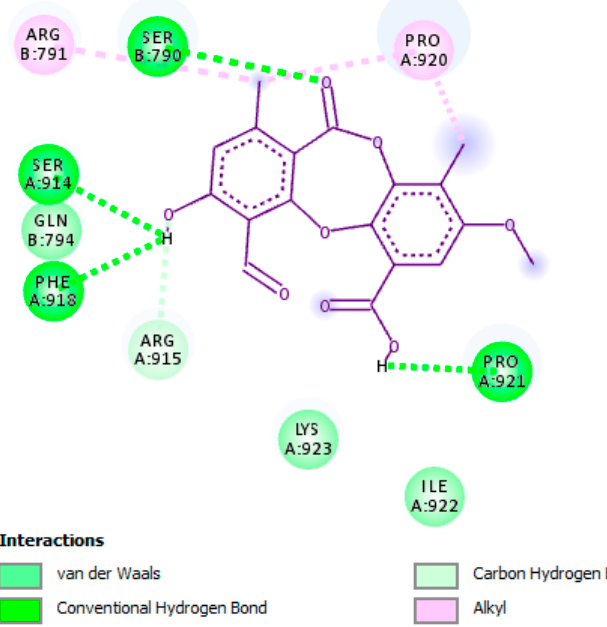
Figure 2. Molecular interaction of psoromic acid (PA) with the active site of HSV-1 DNA polymerase. Amino acid residues involved in HSV-1 DNA polymerase stabilization along with the hydrogen bonding and other essential interactions for enzyme inactivation are presented. The key functional groups of PA that are responsible for anti-HSV-1 DNA polymerase activity are depicted.